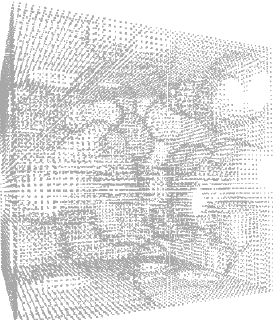
Figure 5. Point cloud for a cubic random foam structure.